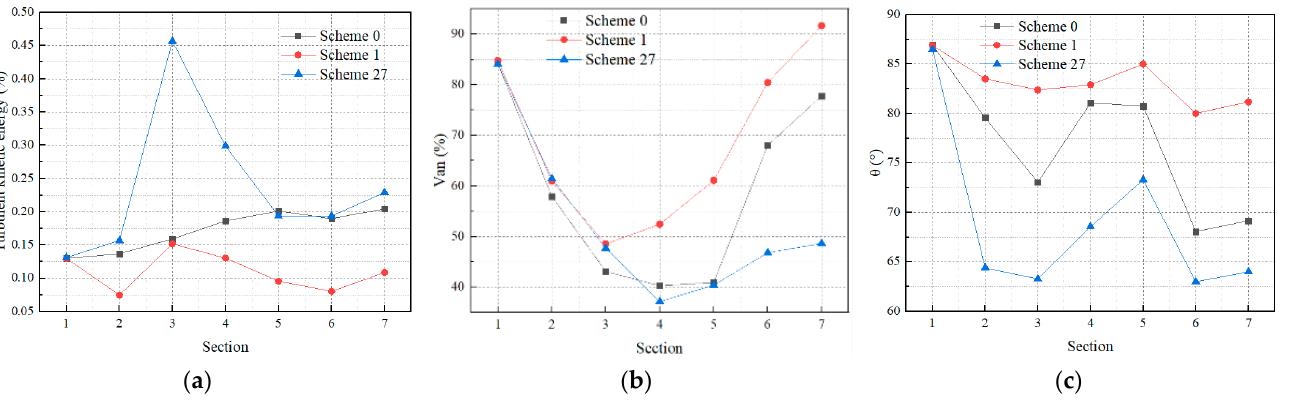
Figure 20. Trend diagram of V an , θ , and the turbulent kinetic energy of characteristic sections. ( a ) Turbulent kinetic energy, ( b ) Normal velocity uniformity, and ( c ) Normal weighted average